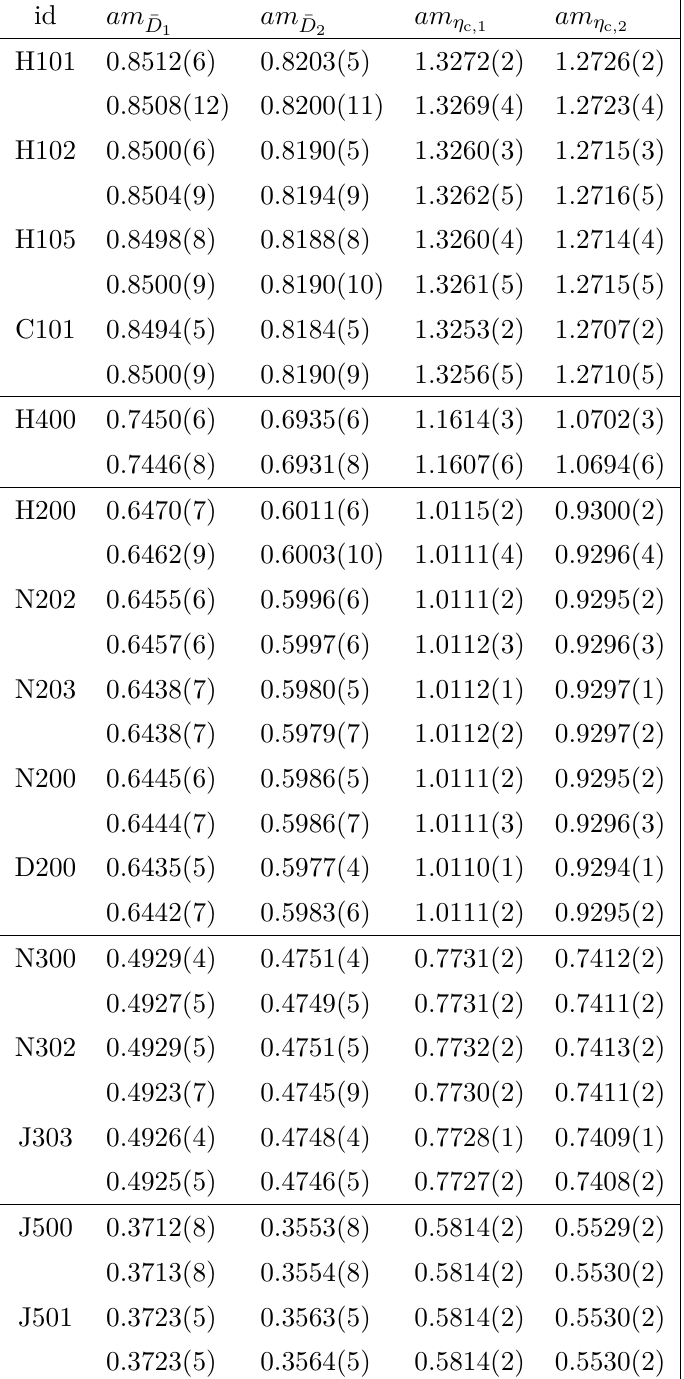
Table 5 . Overview of the results for the flavour-averaged heavy-light and heavy-heavy pseudoscalar meson masses, referring to the two hopping parameter choices in the charm region given in table 2. As before, for every ensemble we list the numbers before the shift in the rows with labels and the corresponding ones after the shift to φ phys in the rows without 4